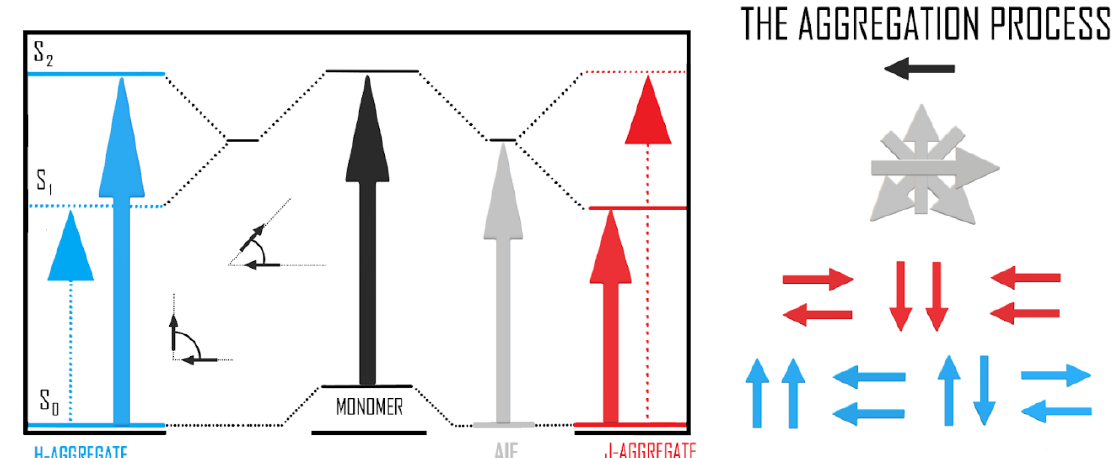
Figure 7. Energy scheme of excited states for various types of aggregates.